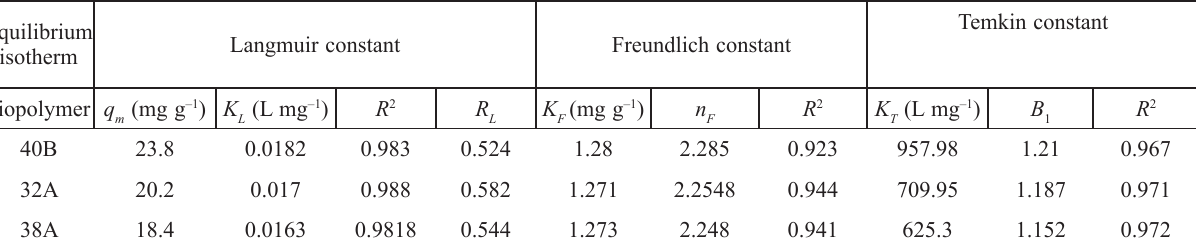
Table 4 – Estimated equilibrium parameters of the three studied equilibrium isotherms for dye adsorption onto the three isolated biopolymers Equilibrium